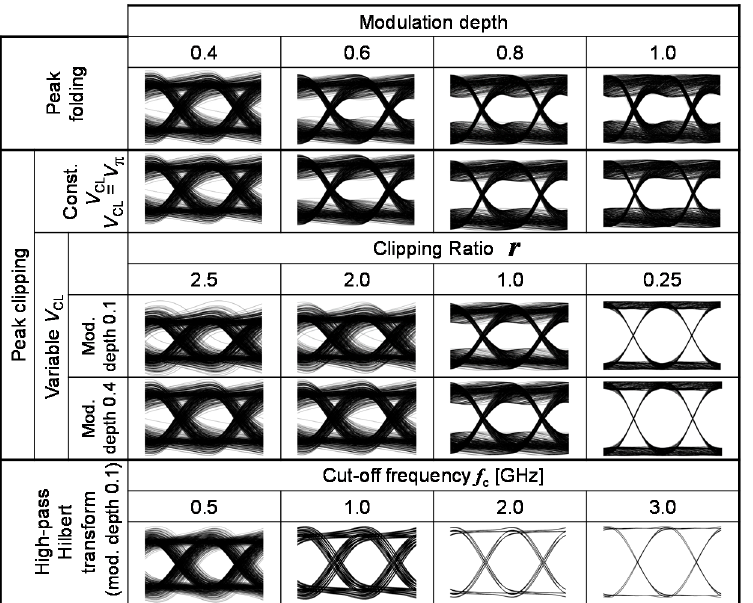
Figure 15. Transmitted signal eye diagrams of PAPR reduced OSSB-SC signal ( P IN 9 dBm, k 20 dB).